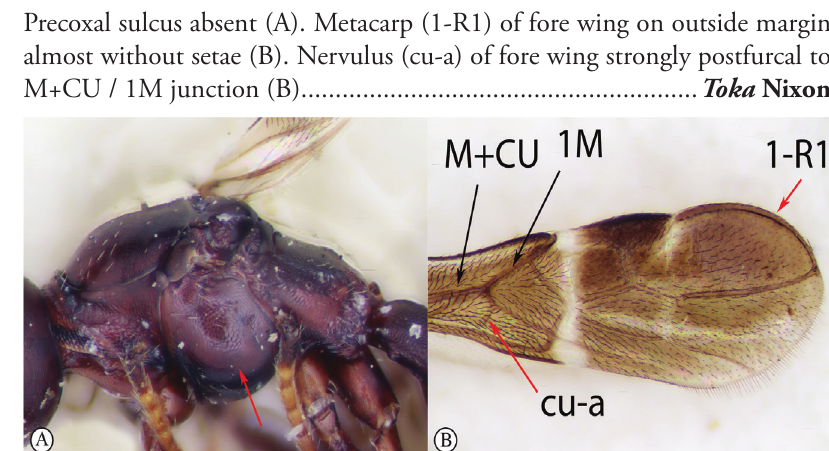
– Precoxal sulcus present (a). Metacarp (1-R1) of fore wing on outside margin densely setose (b). Nervulus (cu-a) of fore wing interstitial, or weakly